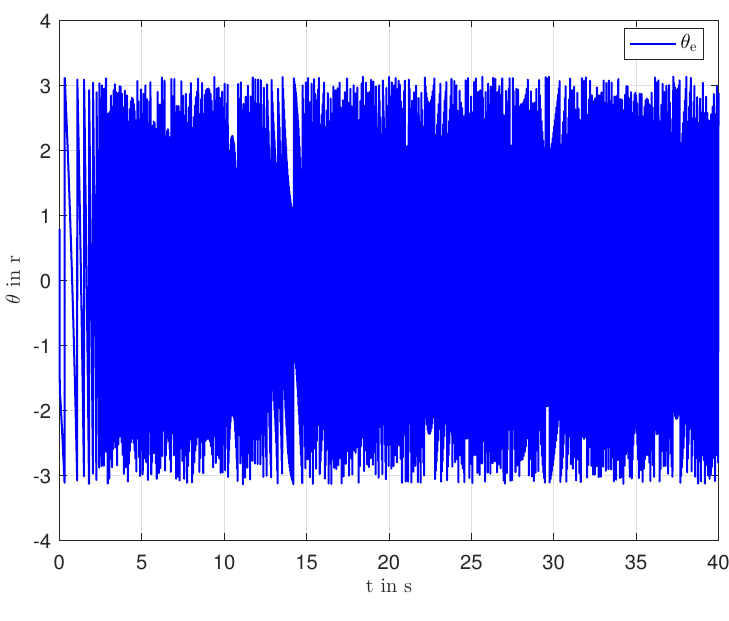
Figure 10. Electrical angle used for RFOC.